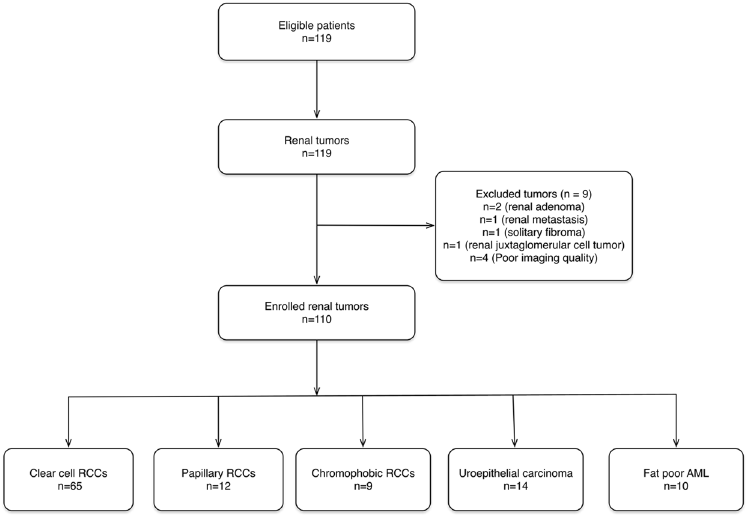
Figure 1. Flowchart of study enrollment. RCC = renal cell carcinoma, AML =